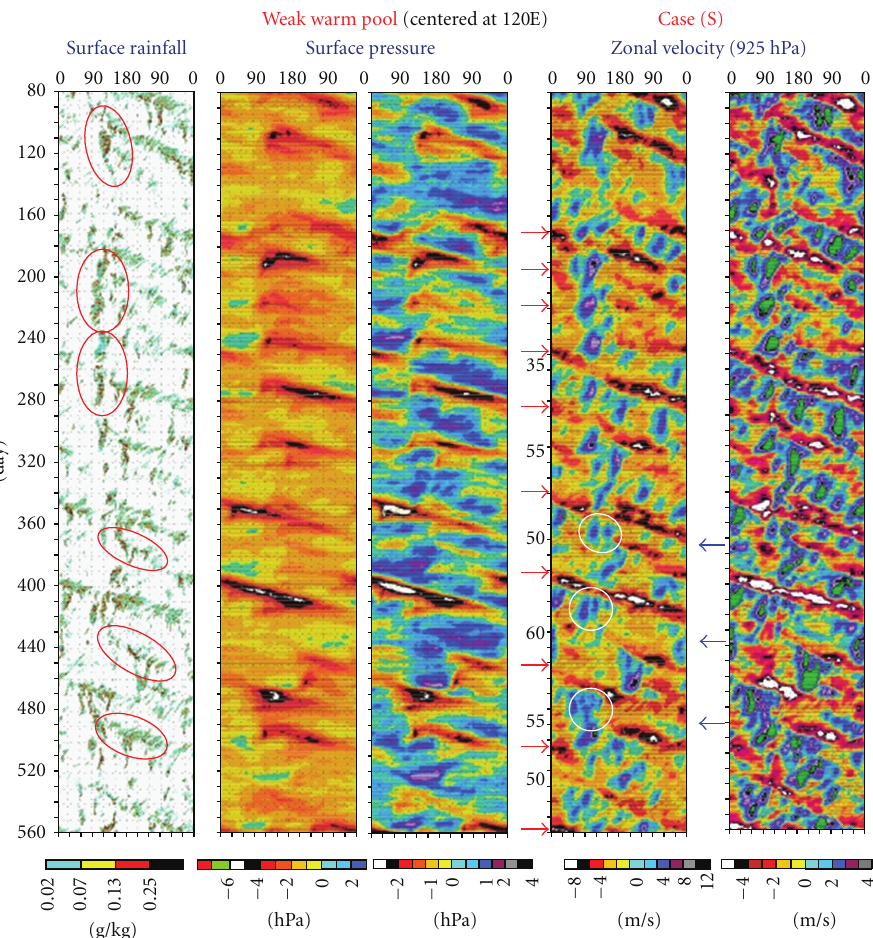
Figure 2: Same as Figure 1 but for case (S). Deviations from time-averaged values are also shown for surface pressure and zonal velocity.